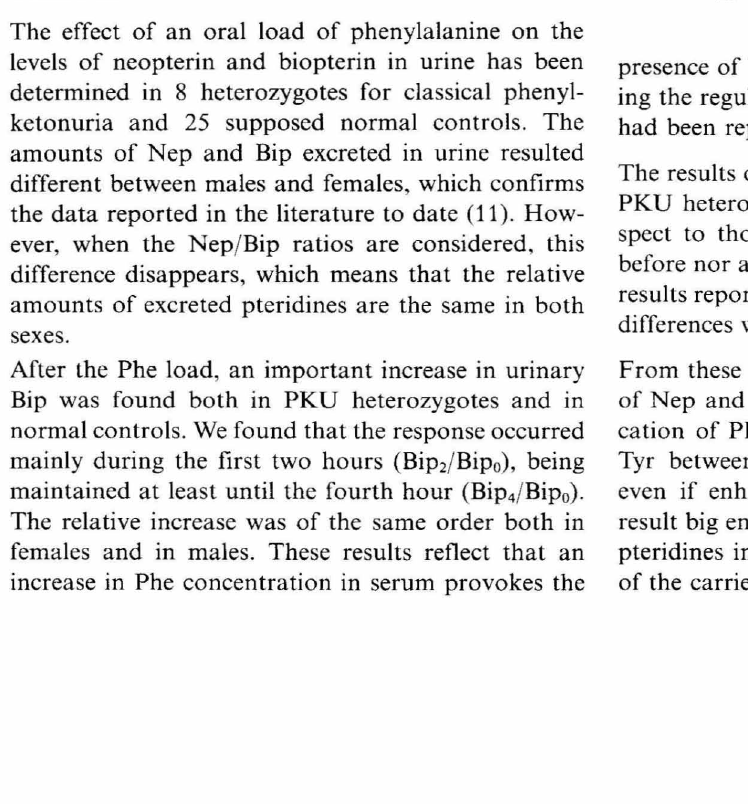
Fig. 1. Relative increases (mean of the individual increases ± SE) in Bip levels in males and females from control and PKU heterozygote groups after an oral load ofL-Phe (100 mg/ kg body weight). Bipz/Bipo, relative increase respect to basal levels in the second hour after the load; Bip4/Bipo, relative increase respect to basal levels in the fourth hour after the load. H, heterozygotes; C,